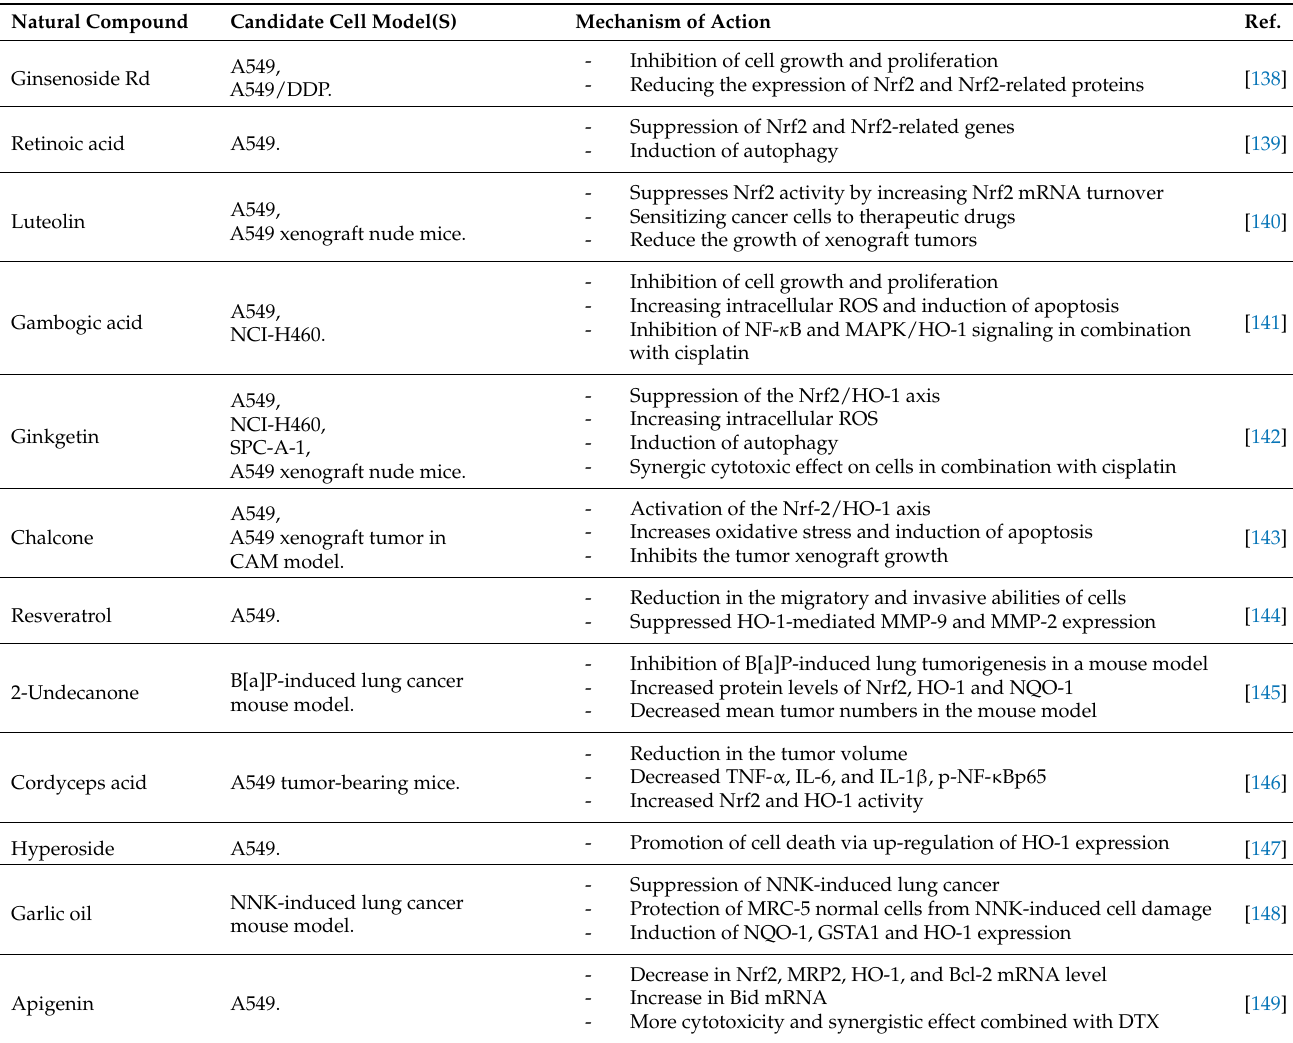
Table 1. Nrf2/HO-1 axis targeting by natural compounds in vitro and in